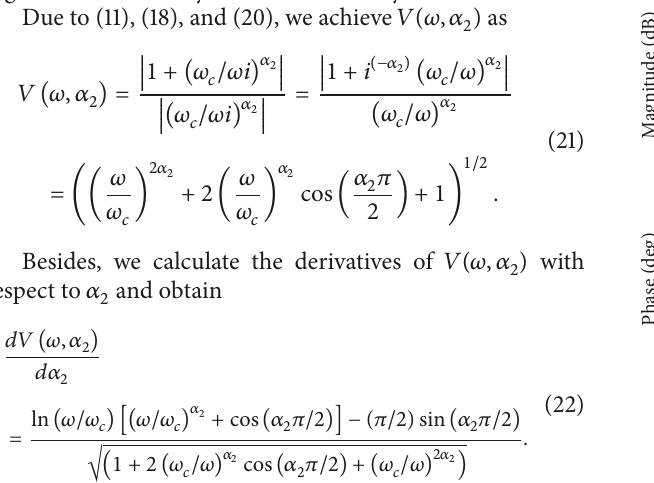
The reference parameters in (8) and controller parameters in (11) tuned by the proposed algorithm are shown in Table 1. The Bode diagram of 𝑃 1 (𝑠) controlled by the proposed controller with reference model parameters 𝜔 𝑐 = 1, 𝜙 𝑚 = 90 ∘ is depicted in Figure 10. It can be seen that the phase curve at crossover frequency is almost flat and the phase margin is 𝜋/2 which satisfies the controller design requirements. The step responses of 𝑃 1 (𝑠) controlled by FOPID controllers tuned ∘ and different crossover with the fixed phase margin 𝜙 𝑚 = 60 frequencies 𝜔 𝑐 = 0.5, 𝜔 𝑐 = 1, 𝜔 𝑐 = 1.5 are shown in Figure 11. Correspondingly, Figure 12 demonstrates the step responses of 𝑃 1 (𝑠) controlled by FOPID controllers tuned with the fixed crossover frequency 𝜔 𝑐 = 1 and varying phase margins 𝜙 𝑚 = 45 ∘ , 𝜙 𝑚 = 60 ∘ , 𝜙 𝑚 = 90 ∘ . The unchanged overshoot and different settling times in Figure 11 and the similar settling time and different overshoots in Figure 12 illustrate the impact of reference model with varying parame- ters. Therefore, different control requirements can be fulfilled by varying reference model parameters 𝜔 𝑐 , 𝜙 and controller parameters. In order to check the robustness of the